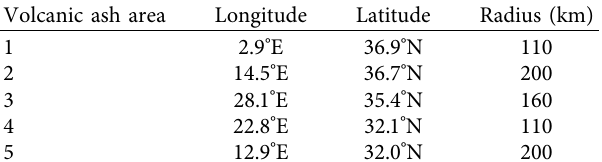
Table 2: Latitude and longitude coordinates and radius of the volcanic ash center.